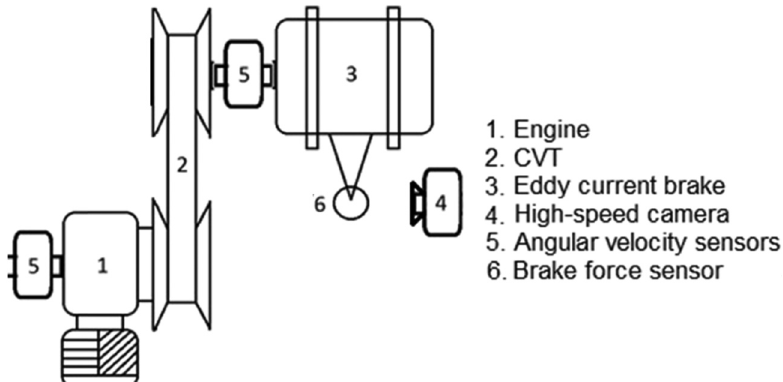
Figure 1: Test stand